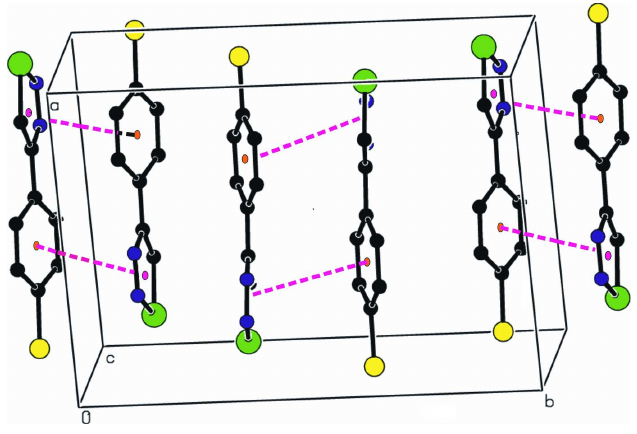
Figure 2 The (cid:2) – (cid:2) interactions between adjacent selenium and phenyl rings for the asymmetric molecule and its partner.